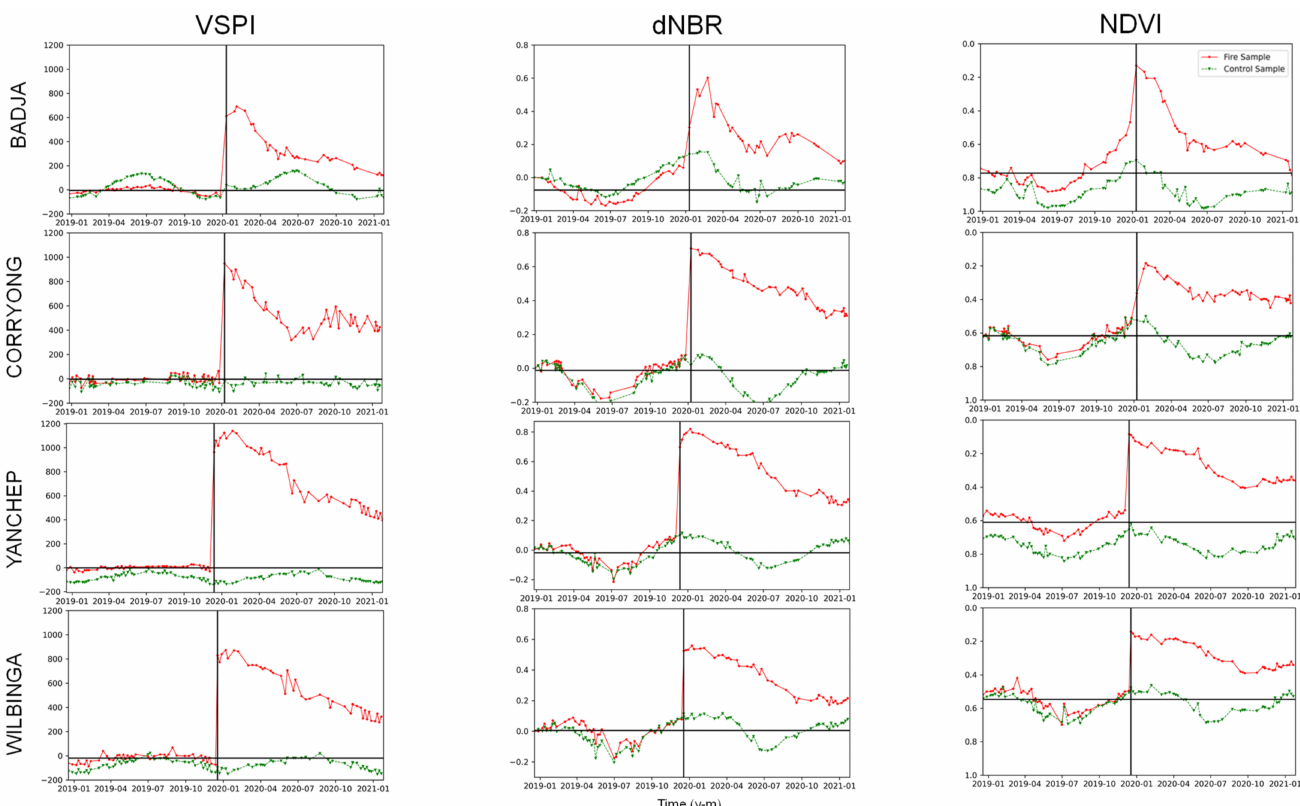
Figure 9. Two-year time series of VSPI, dNBR, and NDVI using Sentinel-2 scaled surface reflectance dataset for the other four selected wildfires. Data are shown for burnt/wildfire samples (red) and control samples (green). The black lines indicate the latest imagery post the wildfire event (vertical) and pre-fire conditions (horizontal, mean of the wildfire sample taken